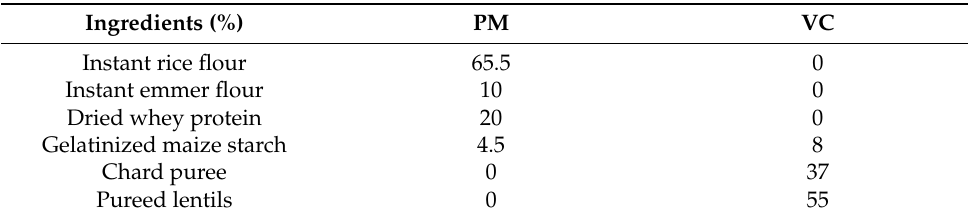
Table 2. Formulations proposed for Protein Meal (PM) and Vegetable Cream (VC). Ingredients (%) PM VC Instant rice flour 65.5 0 Instant emmer flour 10 0 Dried whey protein 20 0 Gelatinized maize starch 4.5 Chard puree 0 37 Pureed lentils